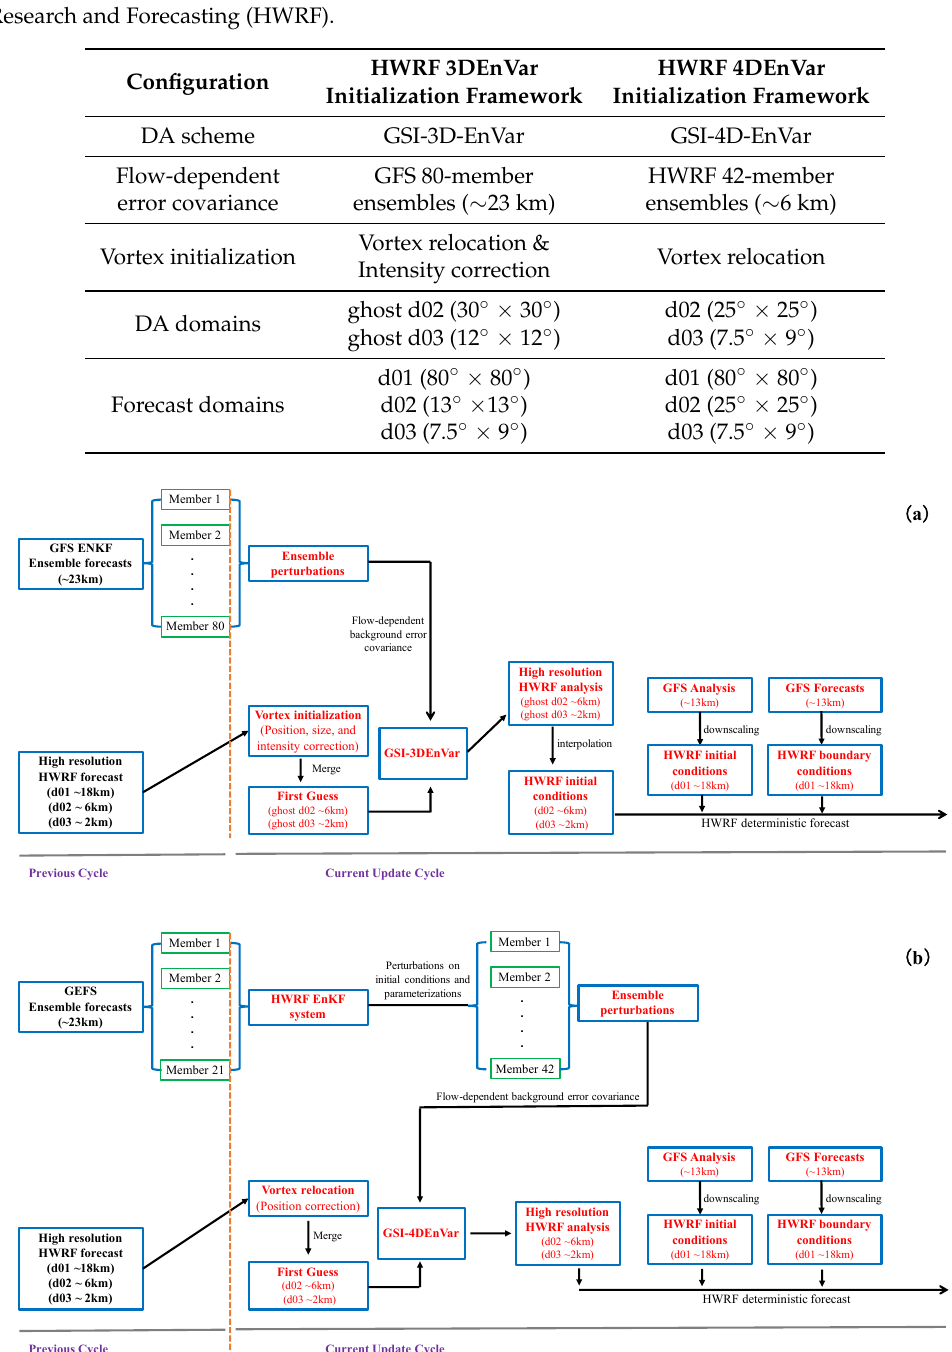
Figure 1. Flow charts for the HWRF simulations based on ( a ) the 3DEnVar initialization framework and ( b ) 4DEnVar initialization